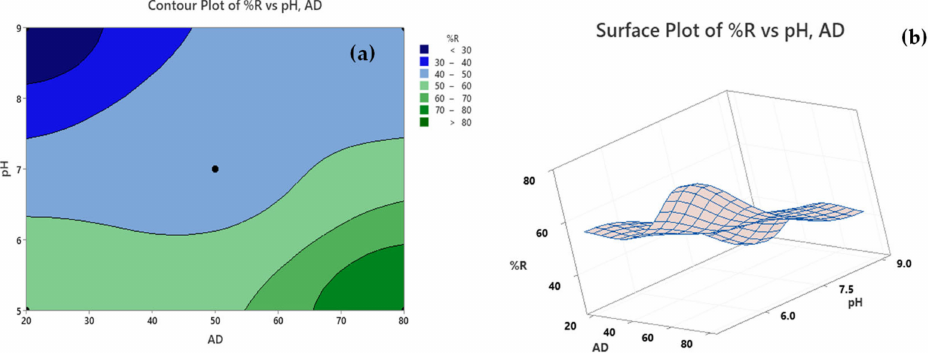
Figure 3. ( a ) Contour and ( b ) Surface plots for %R using RPNS.